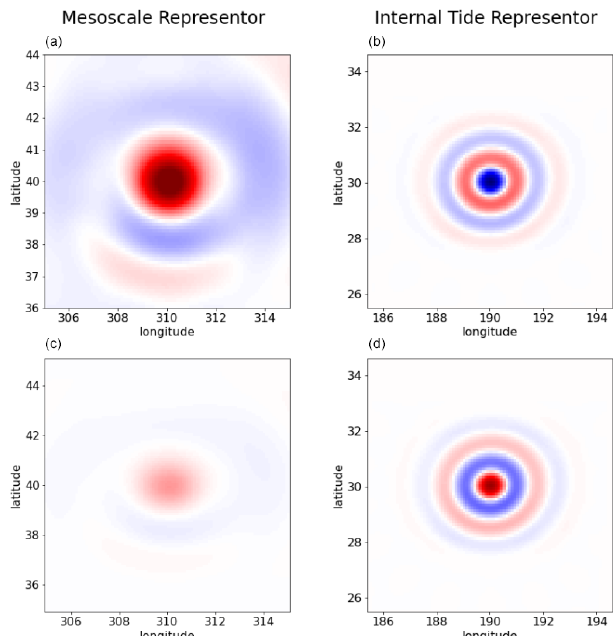
Figure 4. Illustration of the equivalent representer at a given loca- tion, for the mesoscale basis (a, c) and for the internal tide basis (d, b) as a function of space, for zero time lag (a, b) and for 15d time lag (c, d)